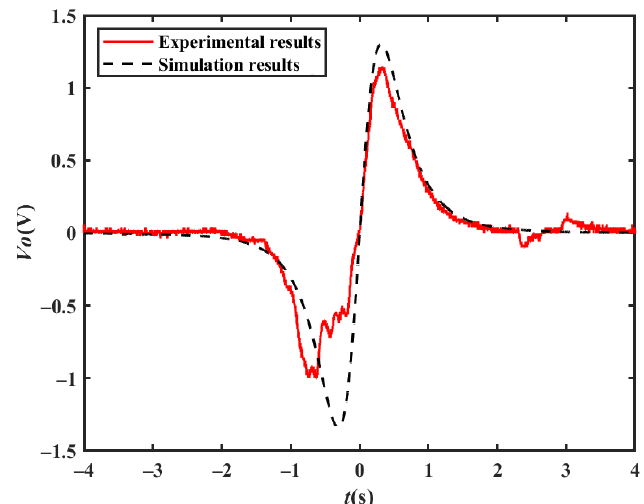
Figure 8. Comparison of experimental and simulation results.